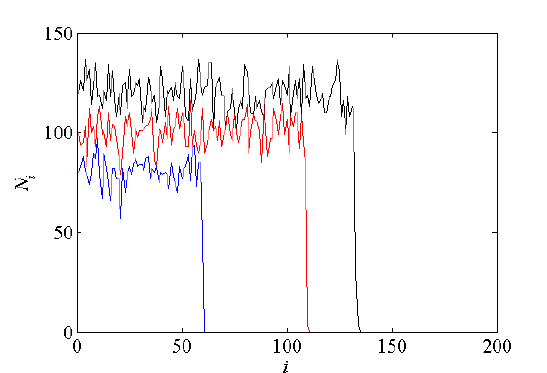
Figure 1 – Schematic plot of the expected per capita offspring E ( O i / N i ) in terms of N i . Horizontal blue line: no Allee effect. Red line: Allee effect with threshold ρ . R is the average per capita growth rate.